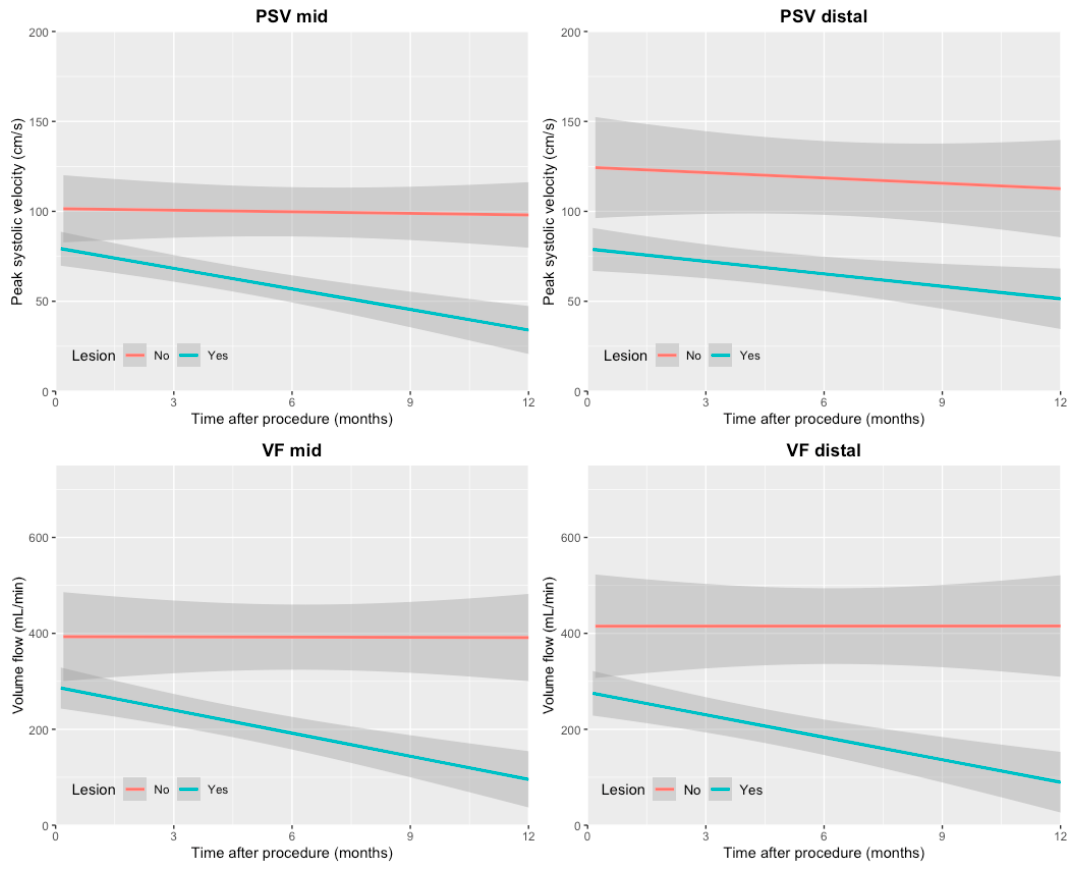
Figure 2. Illustration of the trends of repeatedly measured DUS values over time in patients with and without stenosis or occlusion. The shaded areas indicate the 95% confidence interval.